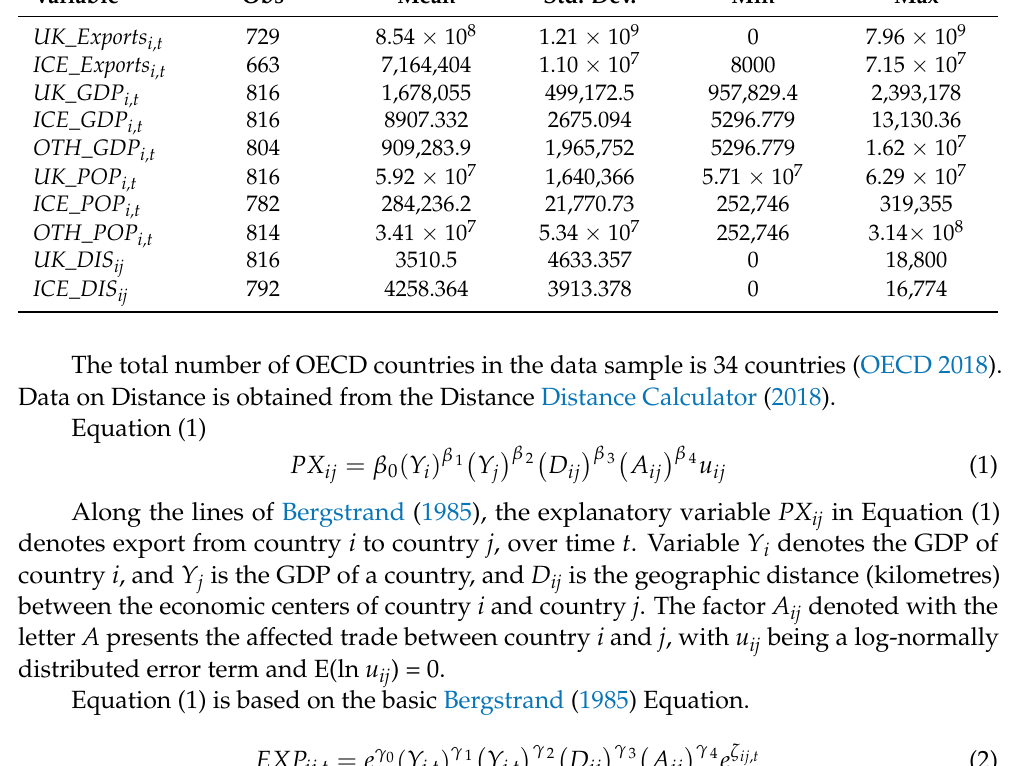
Table 3. Regression for UK exports, using robust standard errors with variable treated by the logarithm function. lnUKexp